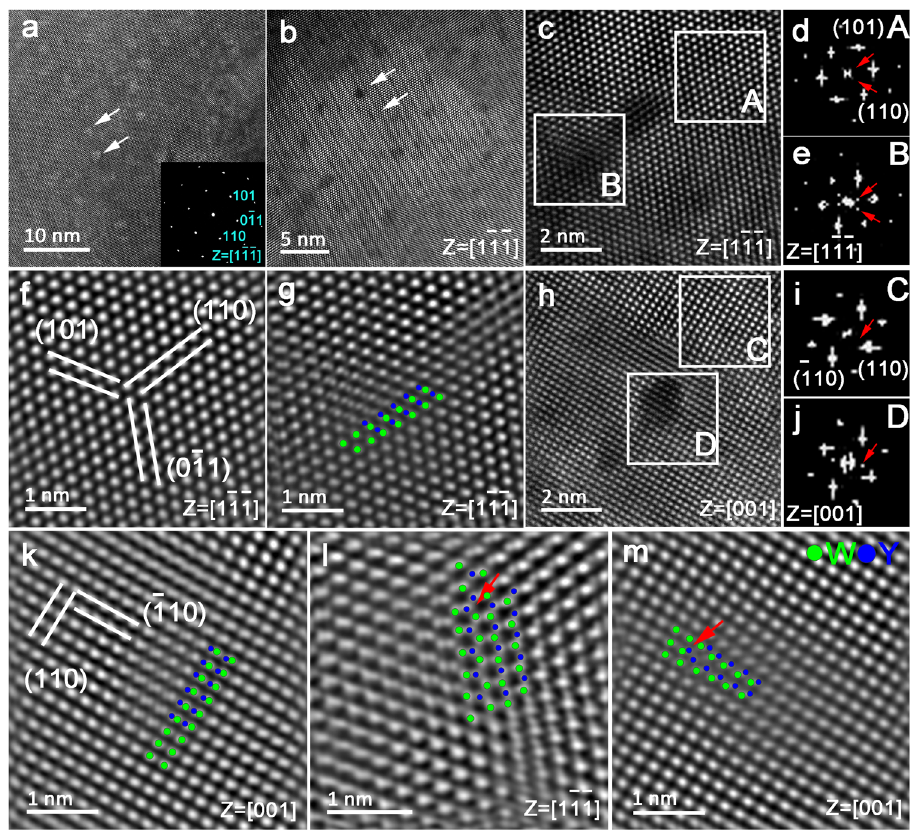
Fig. 2 TEM and HAADF STEM images of intragranular oxide nanoparticles. a, b Bright- fi eld TEM and HAADF STEM images taken from 〈 111 〉 zone axis reveal the existence of intragranular oxide nanoparticles (indicated by white arrows). The inset in a shows the SAED pattern from the corresponding microstructure. c Atomic-resolution HAADF STEM image showing a few coherent oxide nanoparticles. d, e The fast Fourier transform (FFT) patterns taken from W matrix and oxide nanoparticle, respectively, revealing the presence of Y columns along the {110} plane of W matrix. f, g Close-up images of region A and B in c , respectively, highlighting the periodic atomic columns in oxide nanoparticles. h HAADF STEM image taken from 〈 001 〉 zone axis showing the coherent oxide nanoparticle. i, j The FFT patterns are taken from h , revealing the presence of Y columns along the {110} plane of the W matrix. k Close-up image of region D showing the periodic atomic columns in oxide nanoparticles. l , m HAADF STEM images taken from 〈 111 〉 and 〈 001 〉 zone axis, respectively, showing another atomic con fi guration in oxide nanoparticles (denoted by red arrows). W and Y atoms are denoted as green and blue circles, respectively, and superimposed on g , k , l , and m